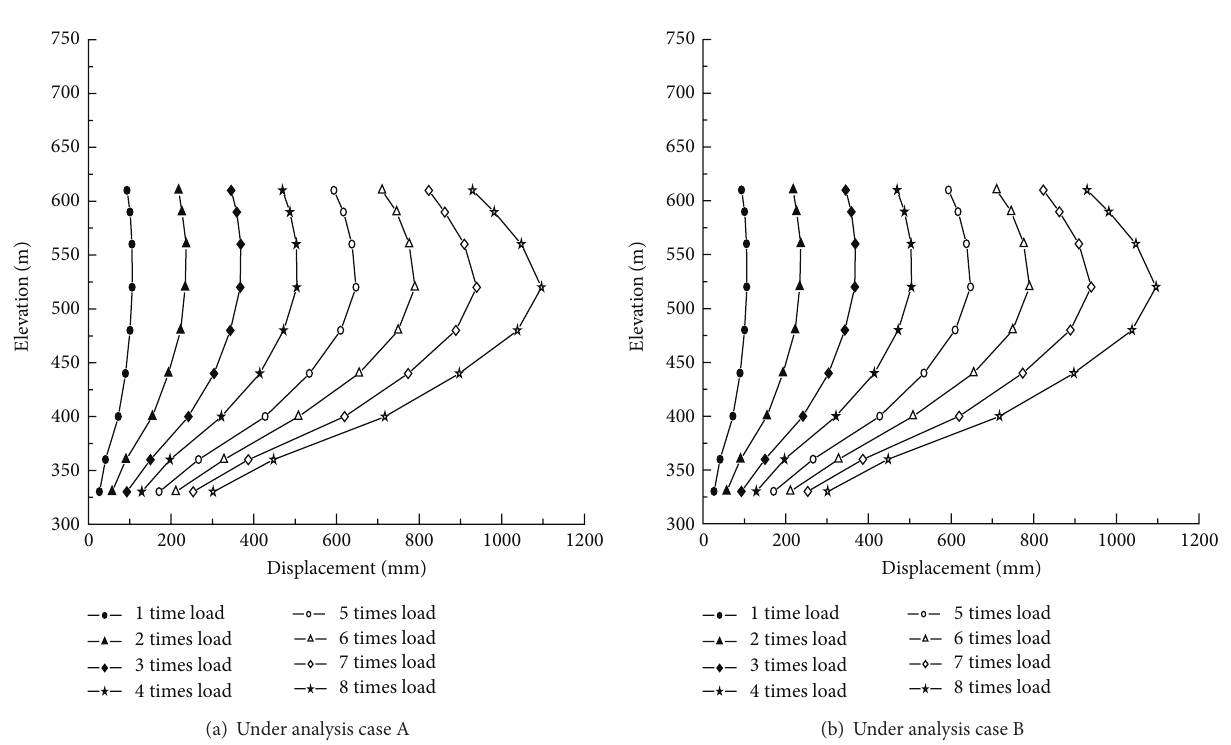
Figure 7: Crown displacement along river direction under various analysis cases (overloading